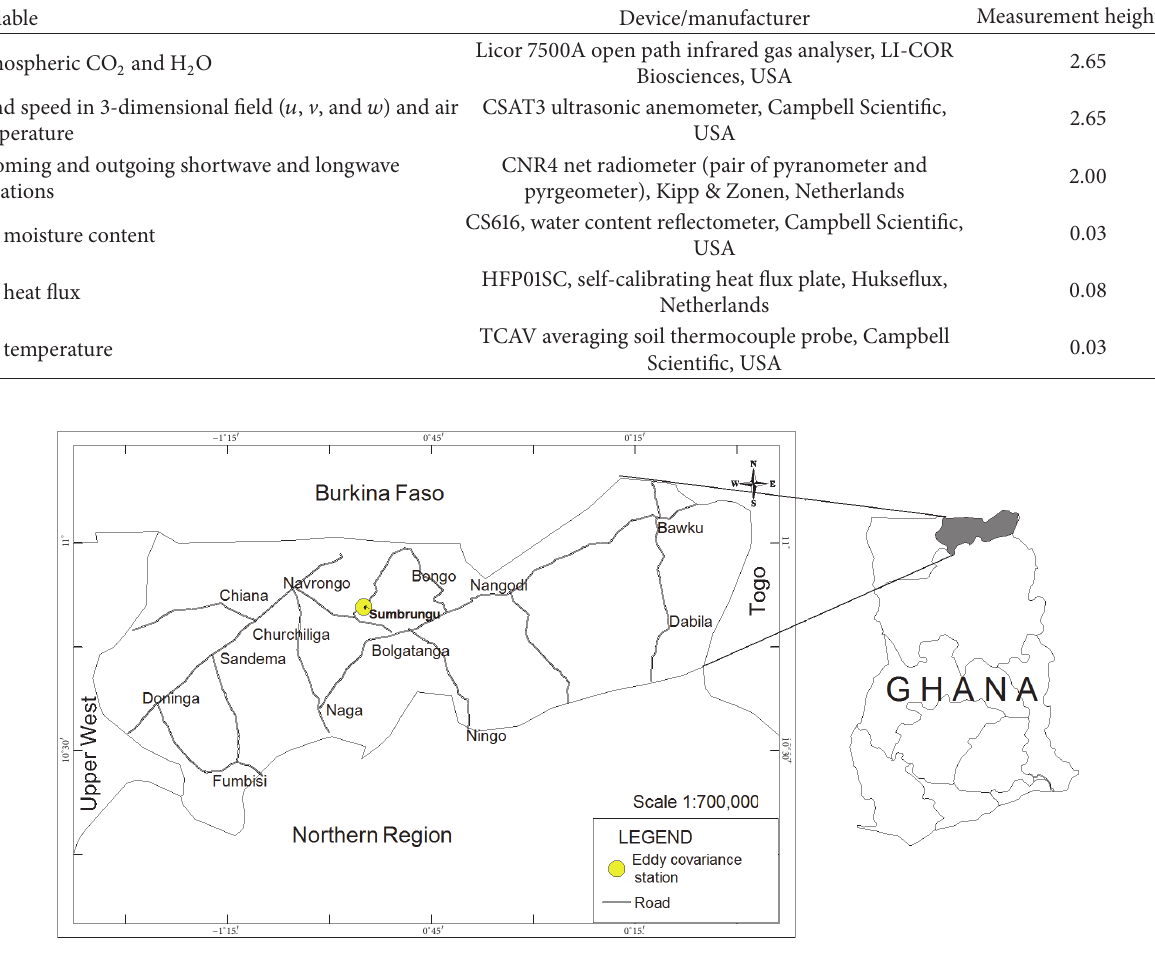
Figure 1: The map of the study sites, including the location of the Eddy Covariance